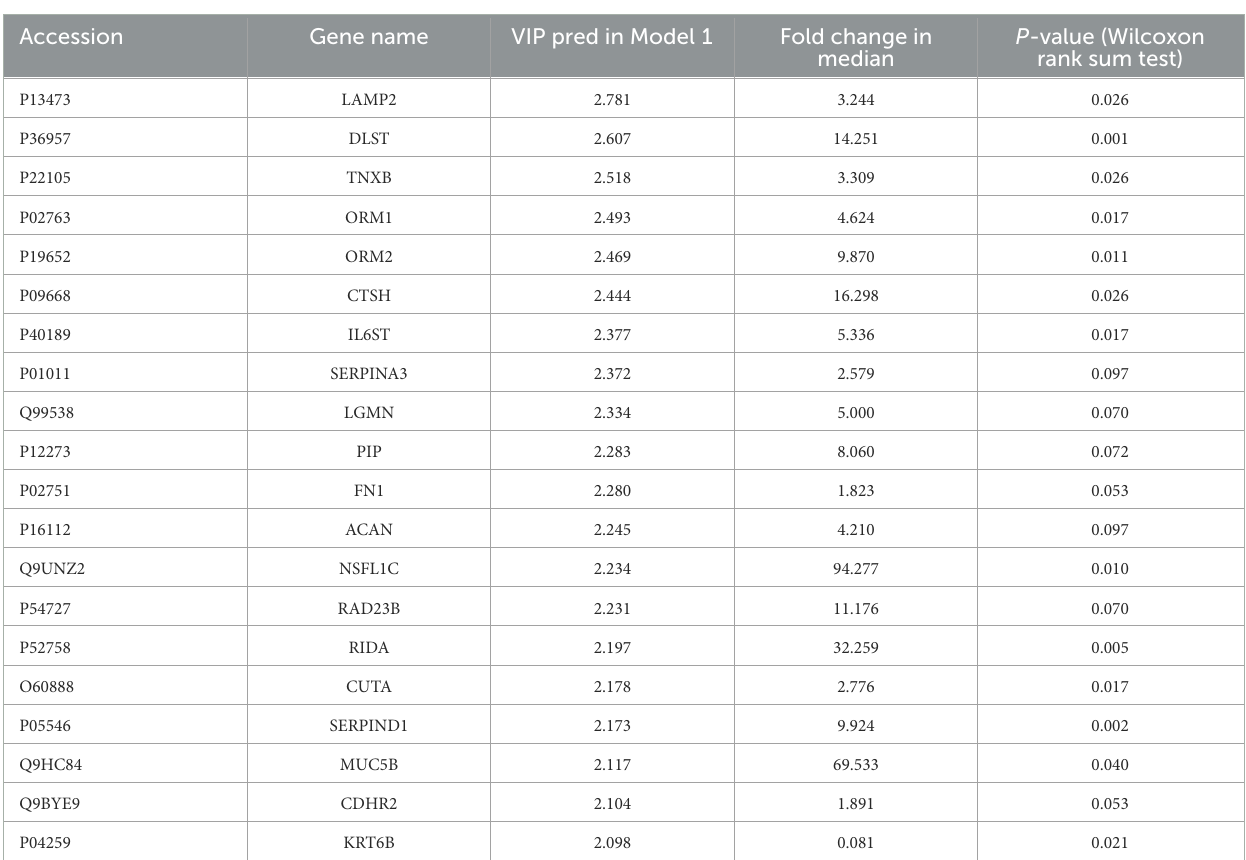
TABLE 1 Proteins included in Model 2.